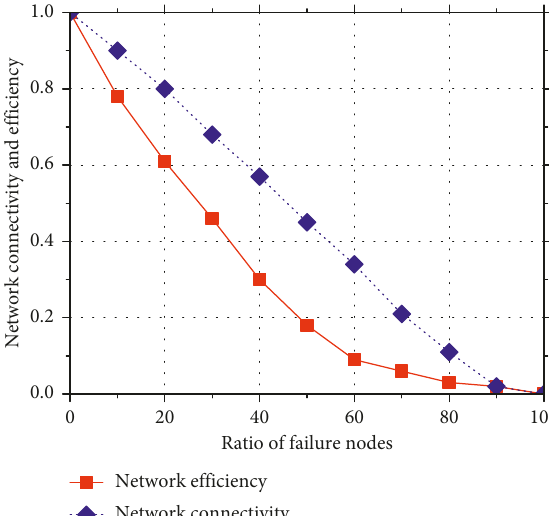
Figure 4: Network connectivity and efficiency.